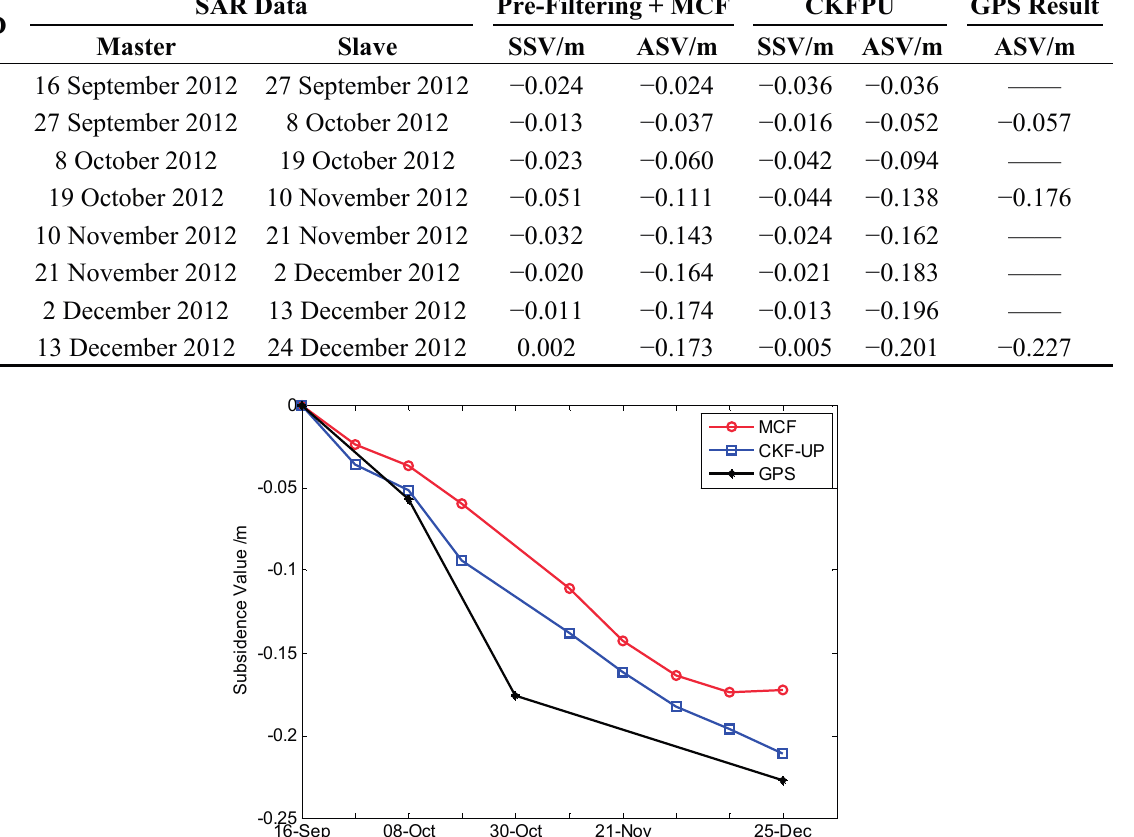
Table 3. Results of MCF and CKFPU.